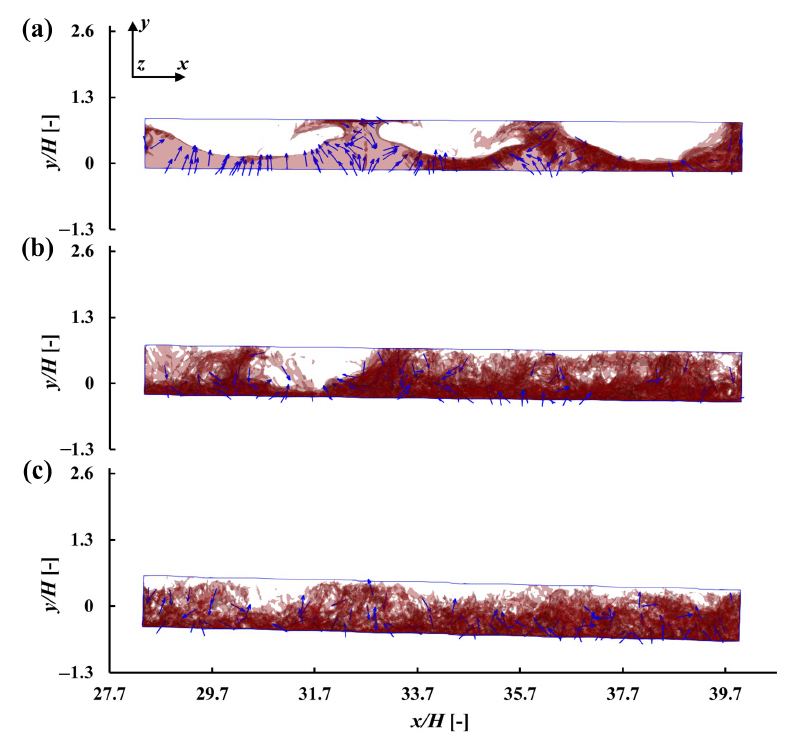
Figure 11. Snapshots for the sloshing tank with N c = 1 at t / T = 8.0 for ( a ) D i = 0.25, ( b ) D i = 0.5 and ( c ) D i = 1.0. Water phase is shown as transparent red with dark red representing the free surface. Blue arrows show the general direction of motion of the sloshing